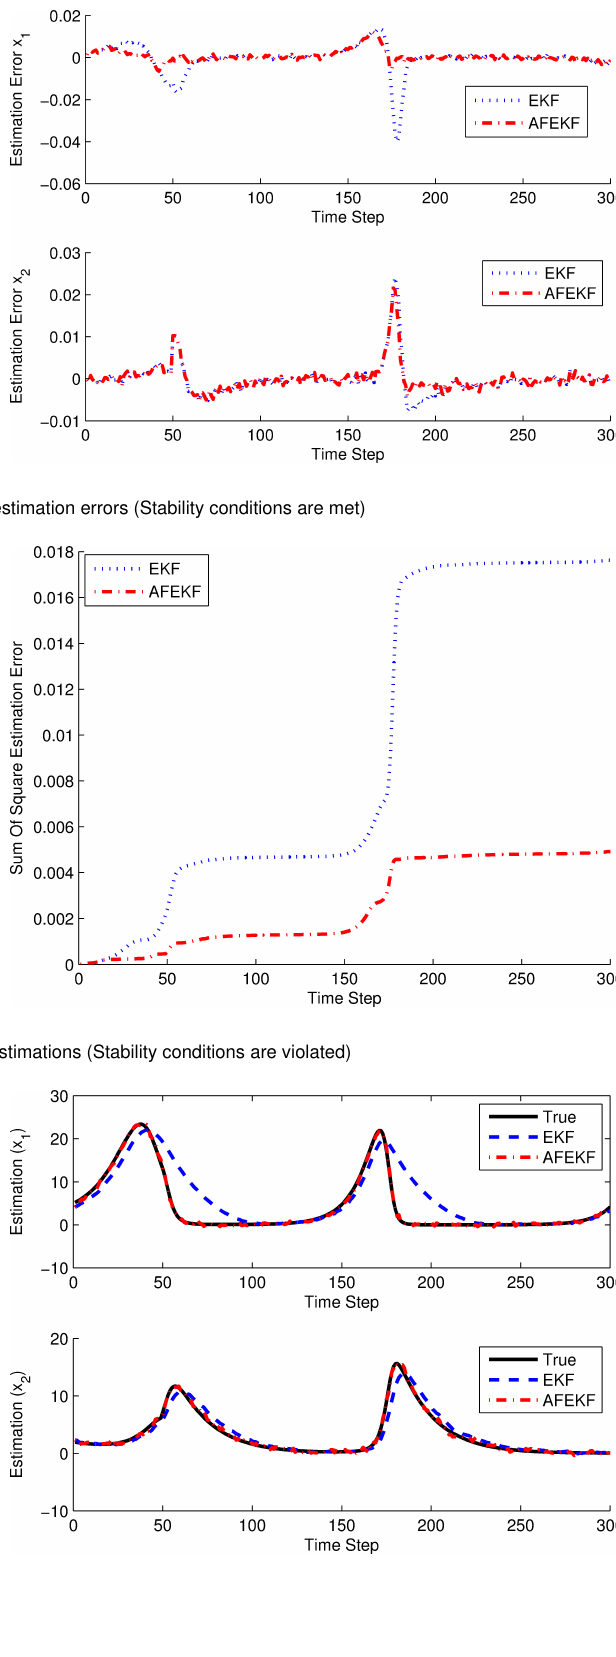
Fig. 1. Estimation error for State 1 and State 2 (Stability conditions are met)